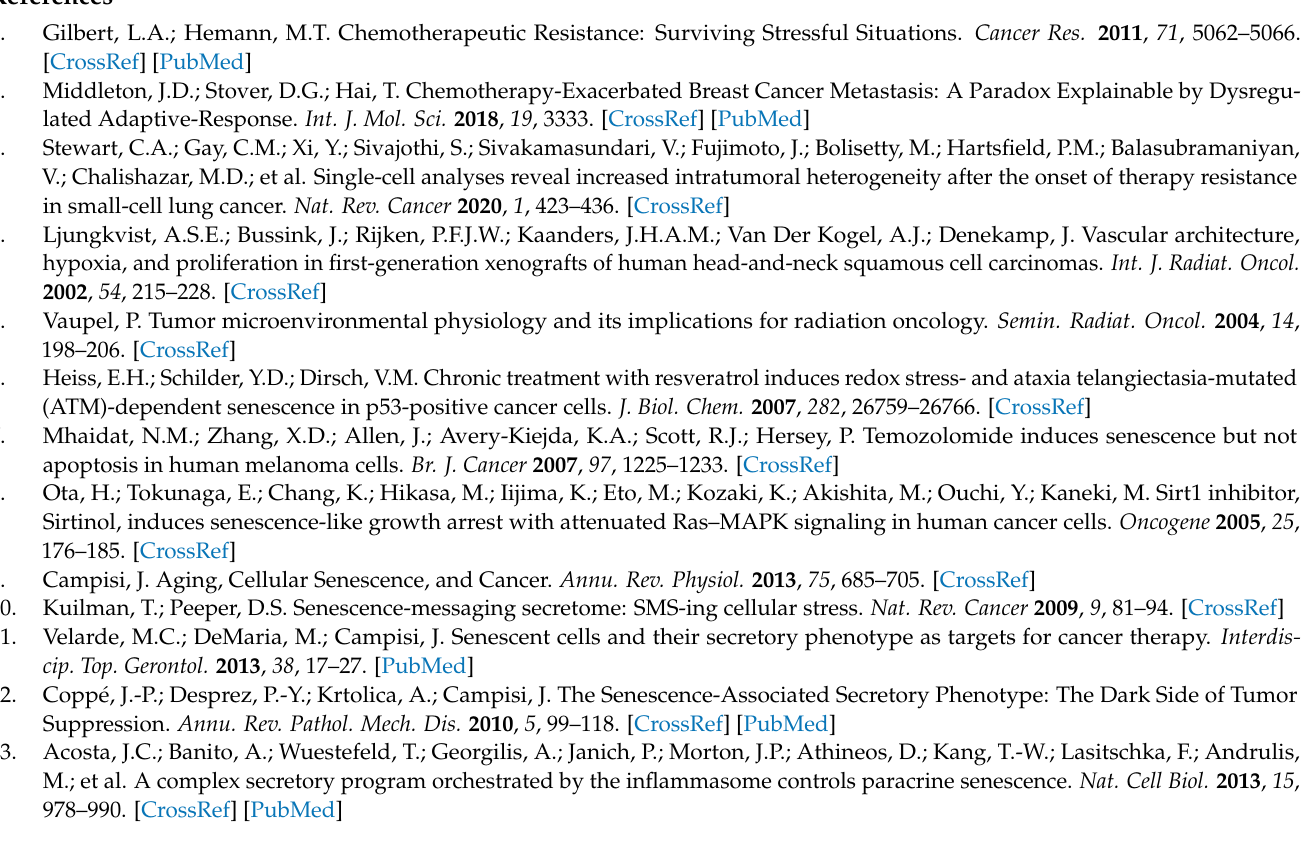
S5: DAPT inhibited EMT progression and Notch signaling of breast cancer MCF-7-luc cells in the co-culture system, Figure S6: The re-entry of senescent MCF-7 breast cancer cells into the cell cycle was independent of activation of Notch signaling after co-culture with adjacent breast cancer cells, Figure S7: Changes in the Wnt signaling pathway in senescent breast cancer MCF-7